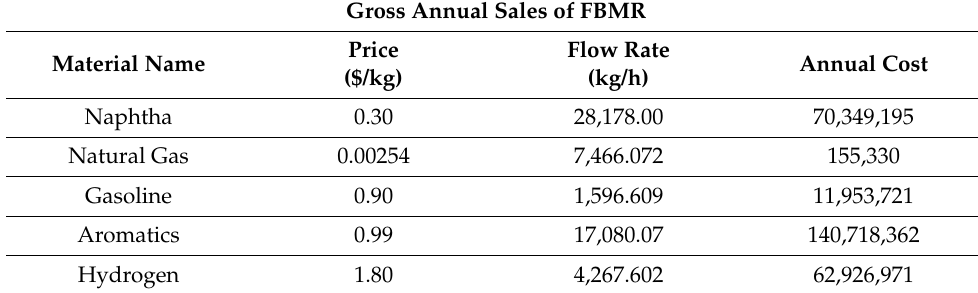
Table 8. Gross annual sales of